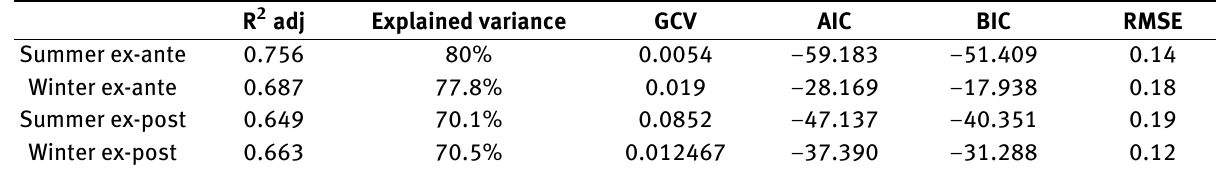
Table 5: Benzene, GAM models performance and summary statistics of leave one out cross-validation (LOOCV) R 2 adj Explained variance GCV AIC BIC RMSE